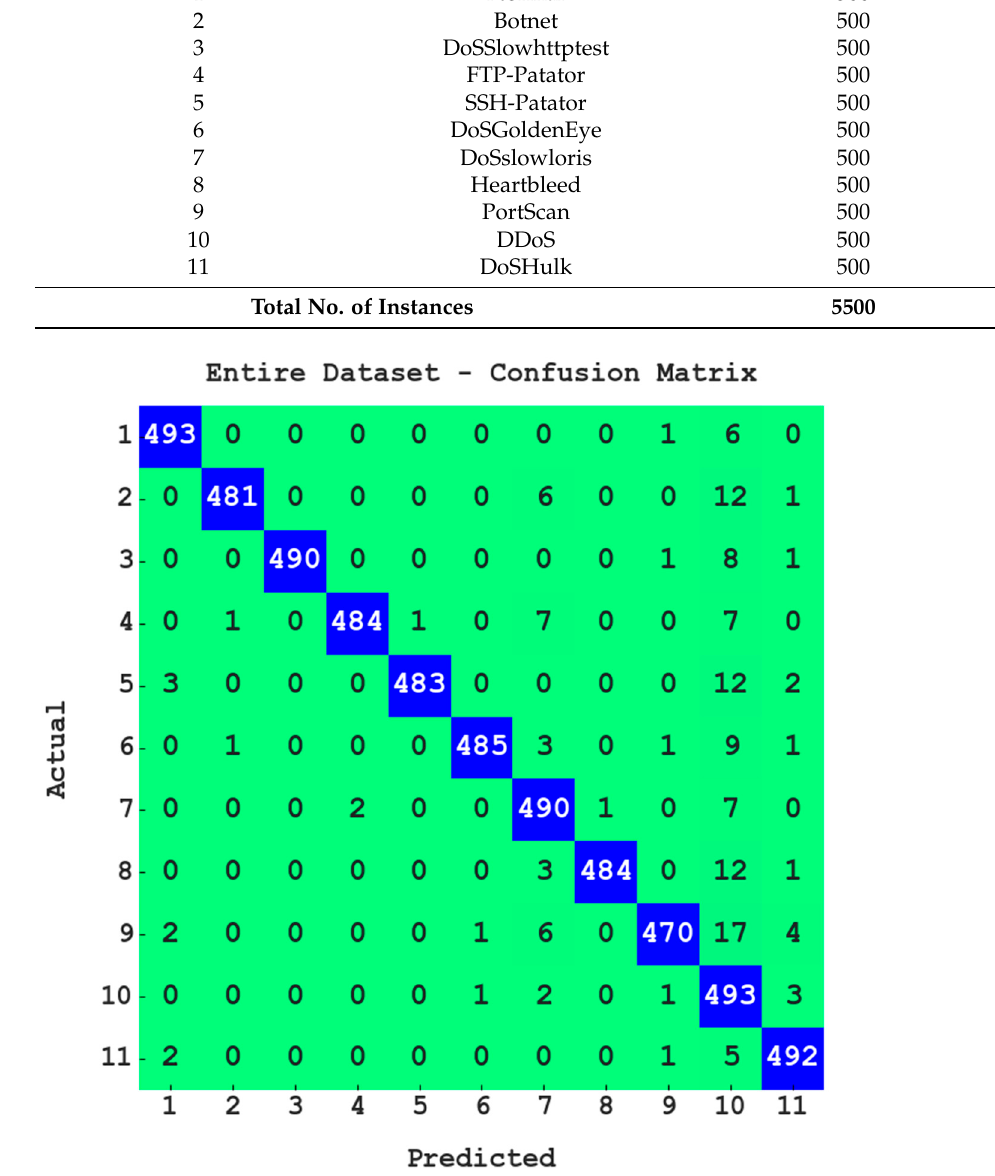
Figure 3. Confusion matrix of PODCNN-LWID approach with entire dataset. Table 2. Result analysis of PODCNN-LWID approach with distinct class labels for entire dataset.